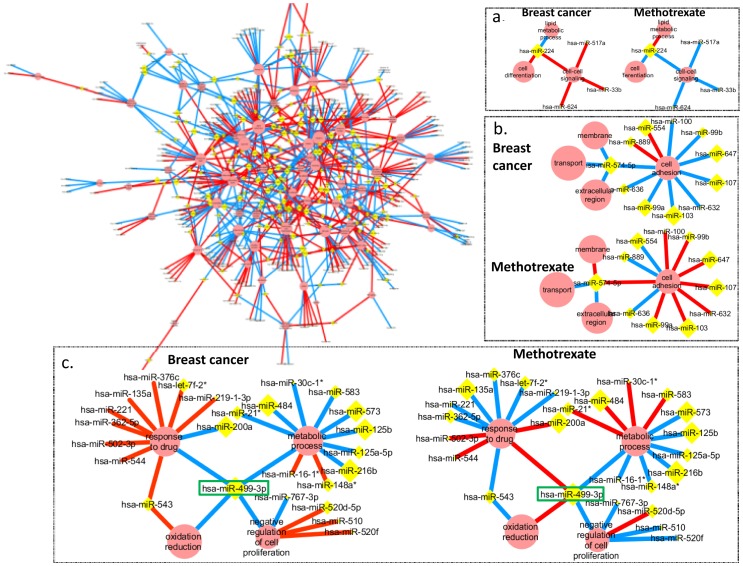
The background newtork is the complete network generated for differential breast cancer data. And three examples of identified cancer associated CoMi sub-networks and their corresponding drug induced CoMi networks.The GO term nodes are represented by red circles and miRNA nodes by yellow diamonds. The figure also shows specific sub-networks for associated with breast cancer (left sub-network) and treatment with Methotrexate (right sub-network) for (a) “cell-cell signaling”, (b) “cell adhesion” and (c) “response to drug/metabolic process/negative regulation of cell proliferation”. The node size is proportional to the degree of the node. The value of the edge of CoMi pattern pair is the CoMi Index and the width of the edge represents the value of -log10(P value). The red edges indicate that the target genes of miRNAs associated with the indicated GO term are down-regulated. Conversely, blue edges indicate the target genes are up-regulated. In each of these three cases the regulation pattern of the breast cancer network is inversely correlated with the regulation pattern for the Methotrexate sub-network.